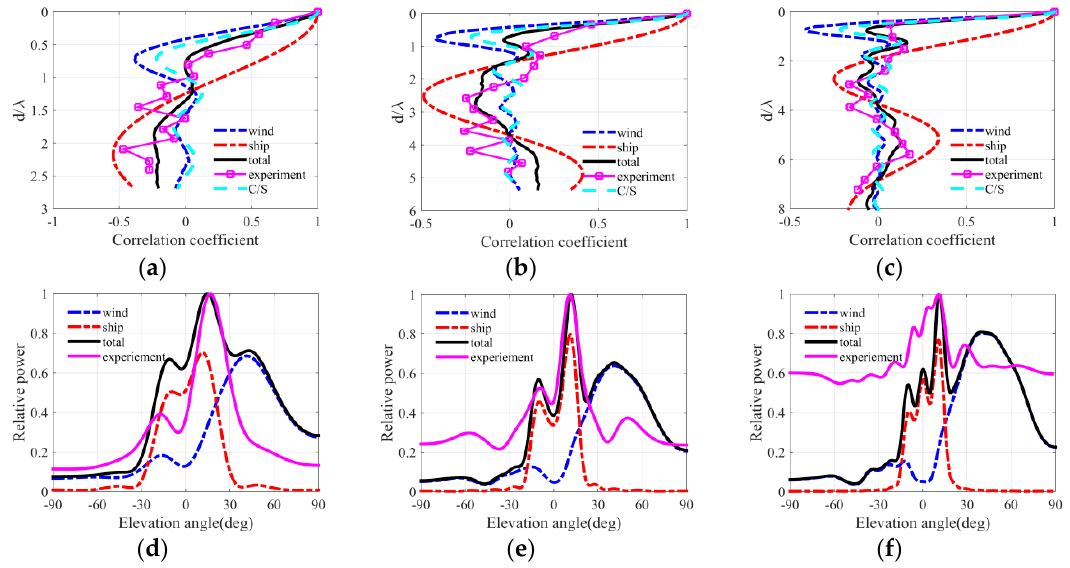
Figure 15. Vertical correlation coefficient and directionality at 22:00, 16 August for frequencies of ( a , d ) 50 Hz, ( b , e ) 100 Hz and ( c , f ) 150 Hz.